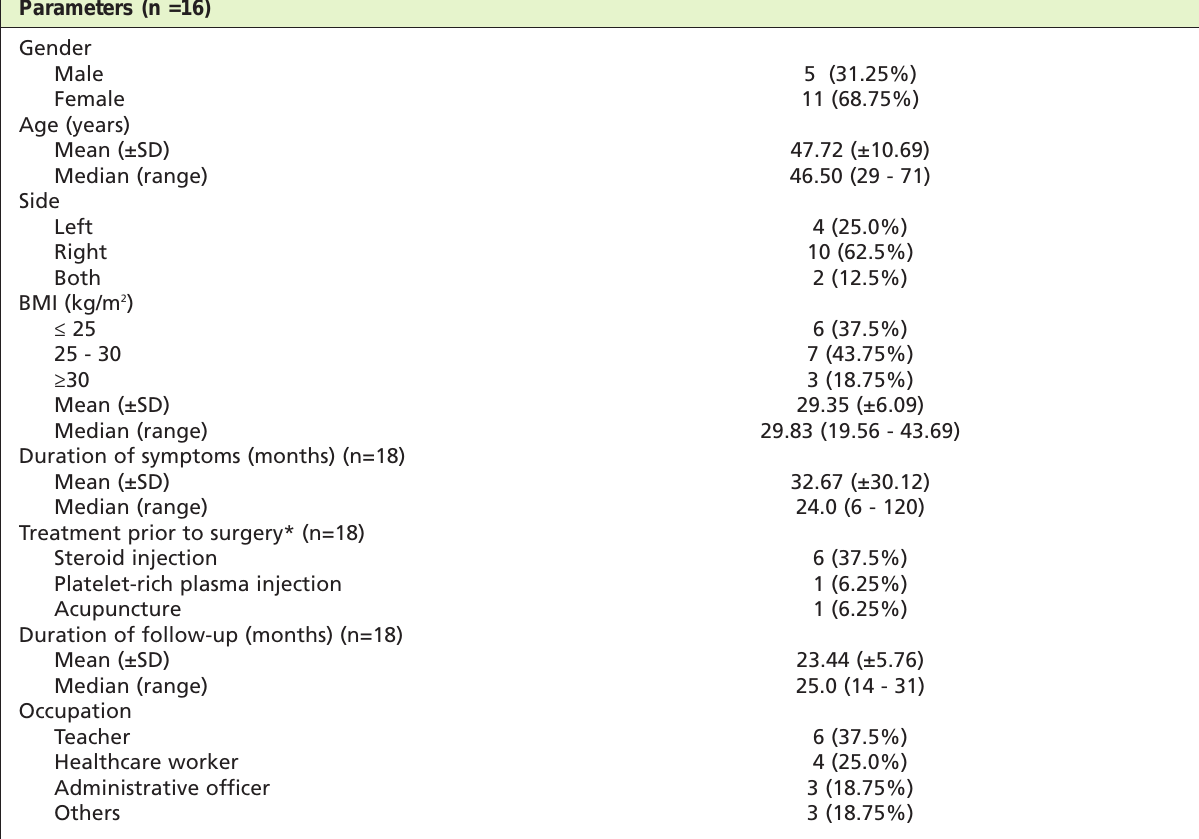
Demographic and perioperative data Table I: